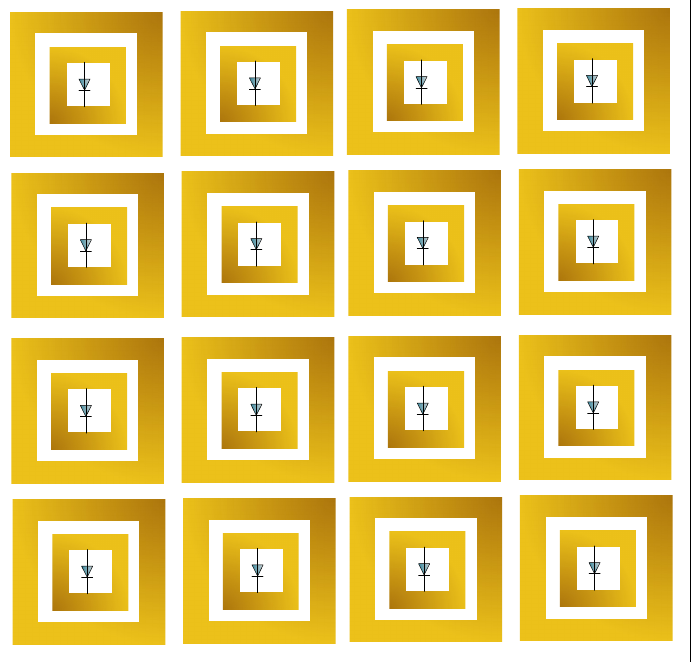
Figure 5. A 4 × 4 RMS integrated with PIN